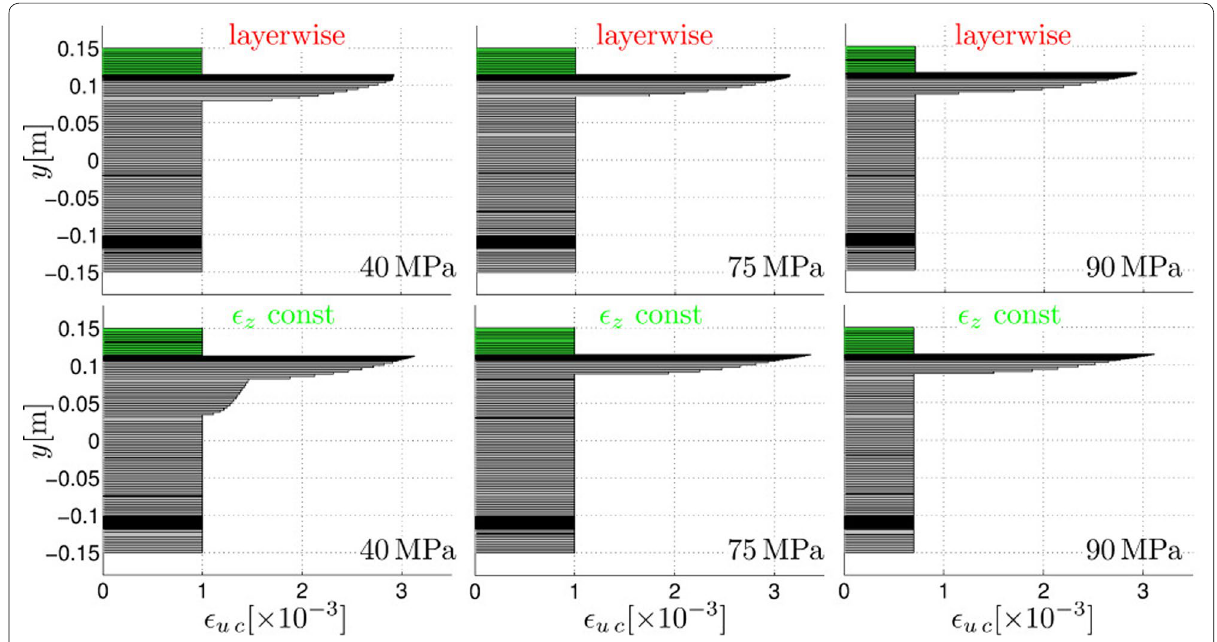
Fig. 12 Ultimate strain in concrete for different stirrup formulations in the cross section of a FE close to mid-span at point D in Fig.